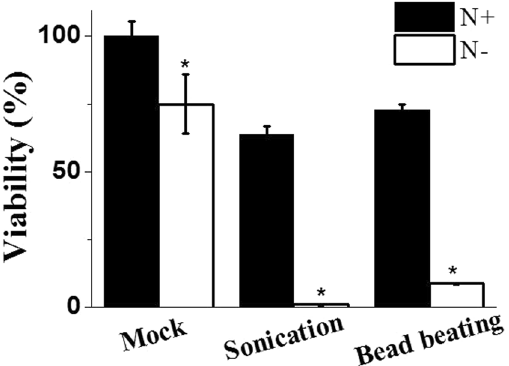
Figure 5. Cell viability after mechanical stress of bead-beating and sonication in N. salina cells grown under N + and N − conditions for 2 days. Each data point represents the mean ± SE of three biological and technical triplicate culture flasks.